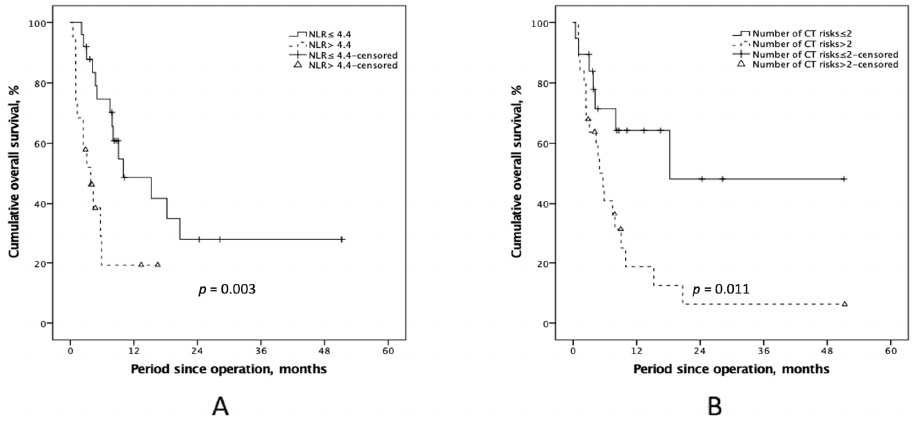
Figure 4. Kaplan–Meier plots of overall survival according to different subgroups that contain with or without the identified survival risks. ( A ) Patients with lower preoperative serum NLR ( ≤ 4.4) demonstrated superior outcomes ( p = 0.003), and ( B ) a more favorable outcome after CRS-HIPEC was deliberated in patients with ≥ 2 CT prognostic risks ( p = 0.011). NLR, neutrophil-to-lymphocyte ratio; CRS-HIPEC, cytoreductive surgery and hyperthermic intraperitoneal chemotherapy; CT, computed tomography. The clinical signi fi cance of the PCI score in peritoneal surface malignancy patients contributing to clinical outcomes is evident but may not be always available preopera- tively. Therefore, we used ROC analyses to examine predictive values of the emerging combination of the two survival risks, identi fi ed from the Cox regression model assessing purely preoperative factors and PCI class, as shown in Figure 5. The patients were cate- gorized into 3 groups by the number of independent survival risks a patient had (14 pa- tients had 0 risk factors, 21 patients had at least 1 risk factor, and 9 patients had both risk factors). There were 10, 12, 16, and 6 patients in the PCI classes I, II, III, and IV, respec- tively. The area under the ROC (AUROC) of the emerging numbers of survival risks in predicting the 6-month mortality, the 12-month mortality, and incomplete cytoreduction were 0.745 (95% CI: 0.597–0.893; Figure 5A ) , 0.737 (95% CI: 0.588–0.885; Figure 5B), and 0.632 (95% CI: 0.466–0.797; Figure 5C), respectively. On the contrary, predictive values of PCI class in the 6-month mortality, the 12-month mortality, and incomplete cytoreduction were 0.709 (95% CI: 0.556–0.863; Figure 5D), 0.675 (95% CI: 0.508–0.841; Figure 5E), and 0.786 (95% CI: 0.642–0.930; Figure 5F), respectively. Although the PCI class showed a good result to predict incomplete cytoreduction, the discrimination ability was mediocre in prognosticating the 6-month and the 12-month survival outcomes. In addition, the emerg- ing preoperative risks scoring seemed to provide valuable information with regards to survival outcomes.